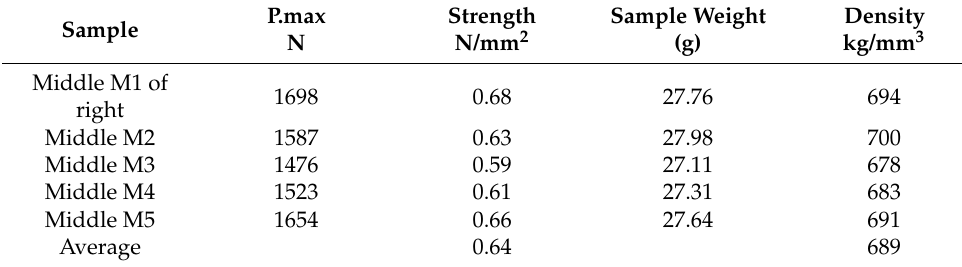
Table 22. Internal bonding test